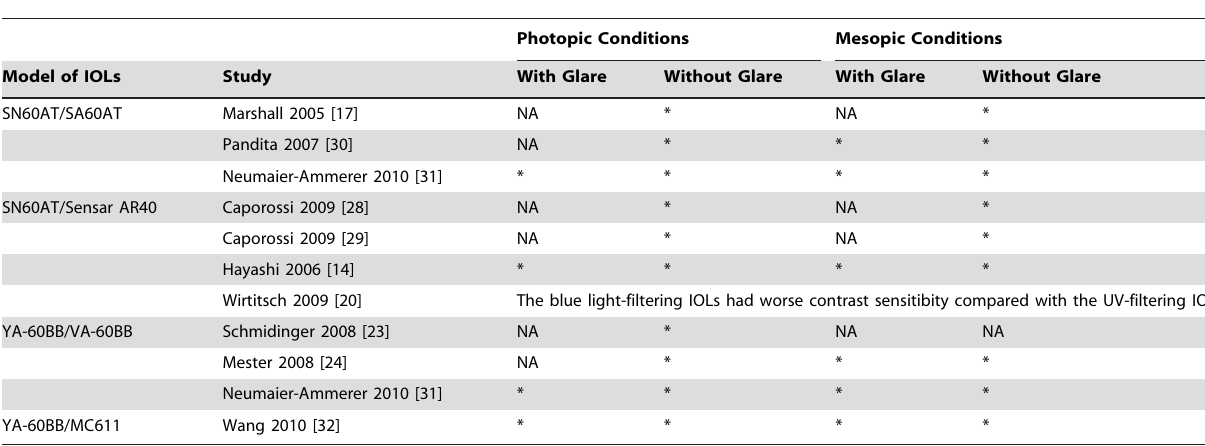
Table 4. Comparison of postoperative contrast sensitivity in two groups.